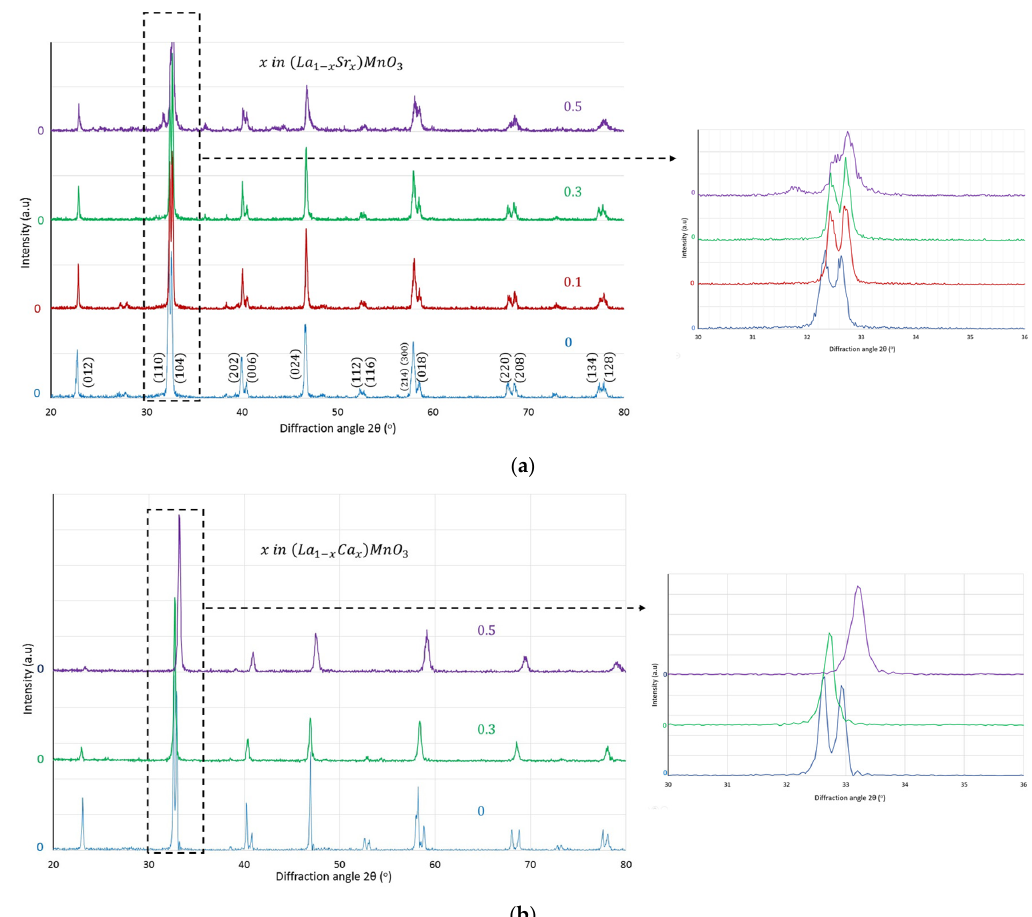
Figure 2. XRD spectra of the as-prepared ( a ) La 1-x Sr x MnO 3 and ( b ) La 1-x Ca x MnO 3 materials.